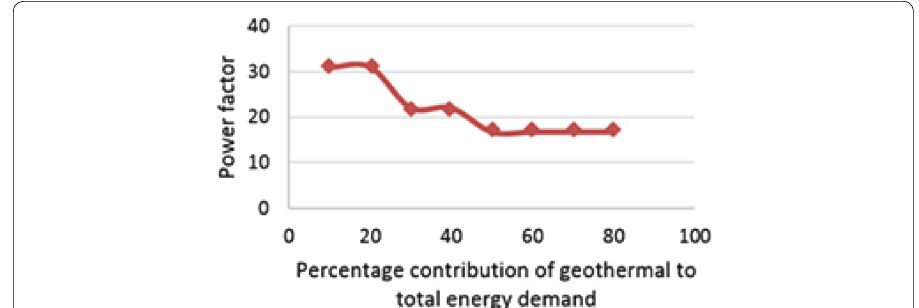
Fig. 8 Power factor versus percentage contribution of geothermal energy to the total energy